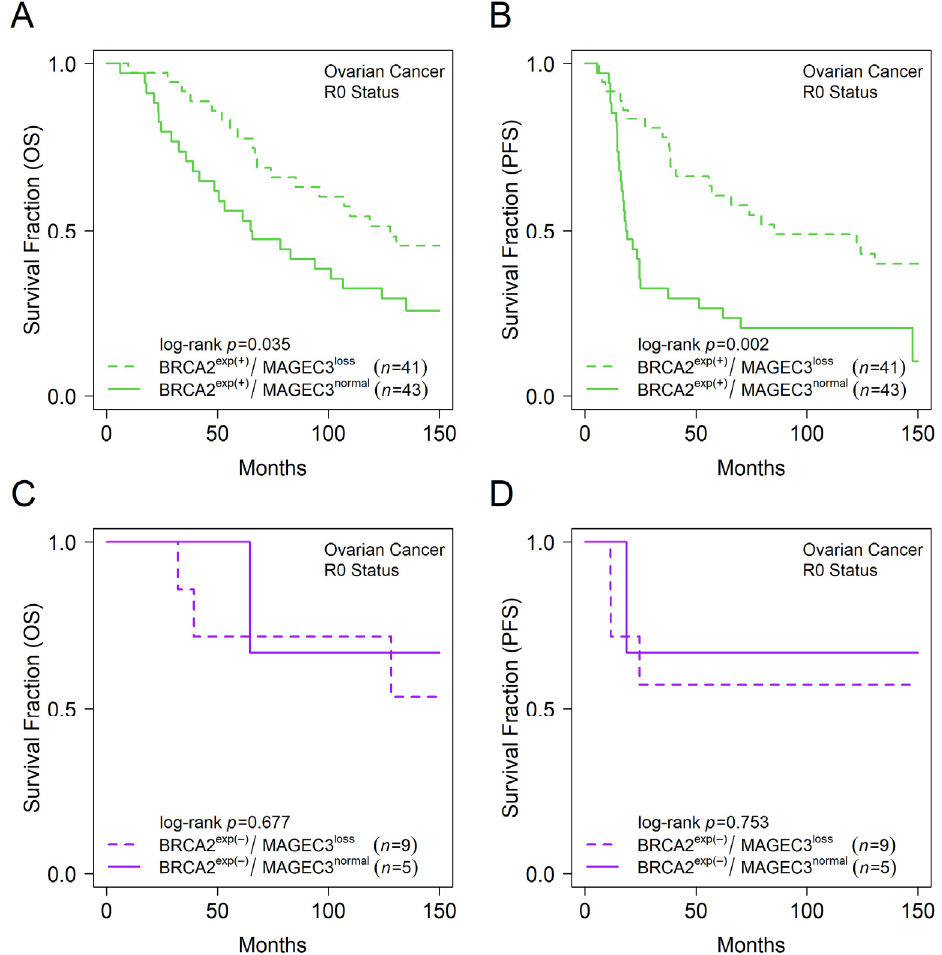
Figure 4. Expression of MAGEC3 and BRCA2 predict outcomes in ovarian cancer patients with optimal cytoreduction. Kaplan–Meier plot showing ( A ) overall survival trends for MAGEC3 normal and loss cases in BRCA2 expressors, ( B ) progression-free survival trends for MAGEC3 normal and loss cases in BRCA2 expressors, ( C ) overall survival trends for MAGEC3 normal and loss cases in BRCA2 non-expressors, ( D ) progression-free survival trends for MAGEC3 normal and loss cases in BRCA2 non-expressors for ovarian cancer patients with optimal cytoreduction.